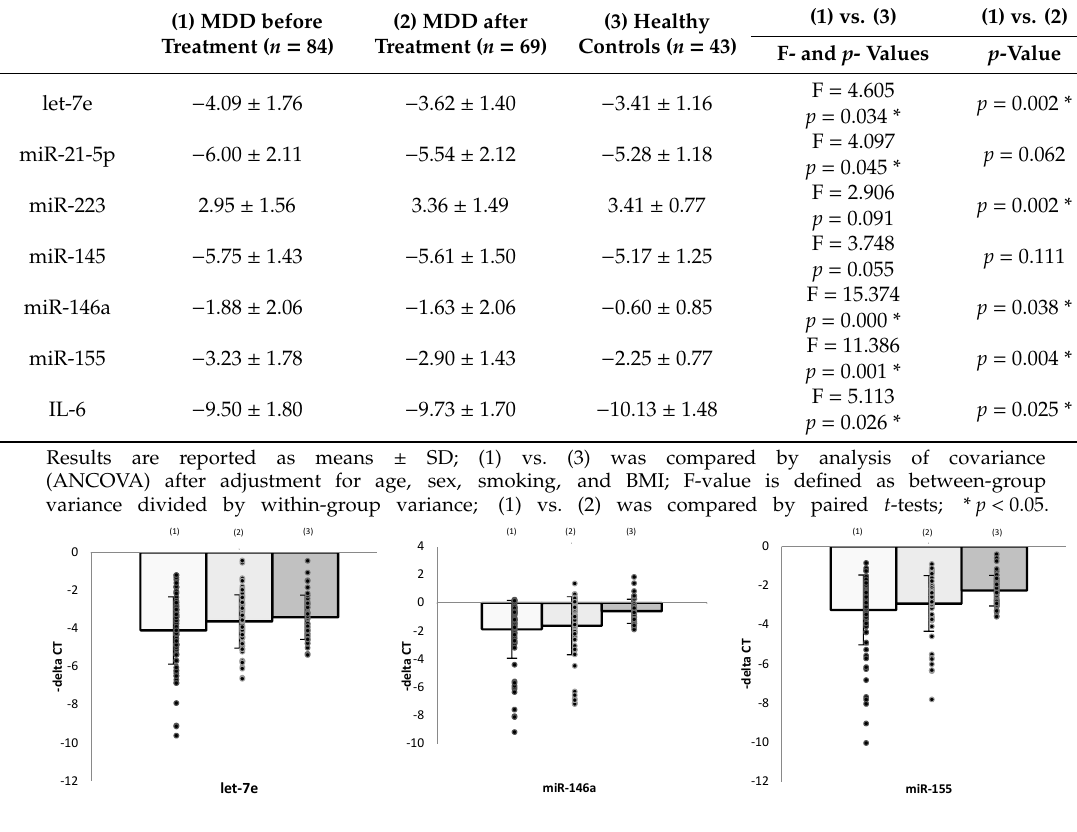
Table 2. Expression in peripheral blood mononuclear cells (PBMCs) of individual microRNAs regulating Toll-like receptor (TLR) signaling in patients with major depressive disorder and healthy controls. IL-6—interleukin-6.